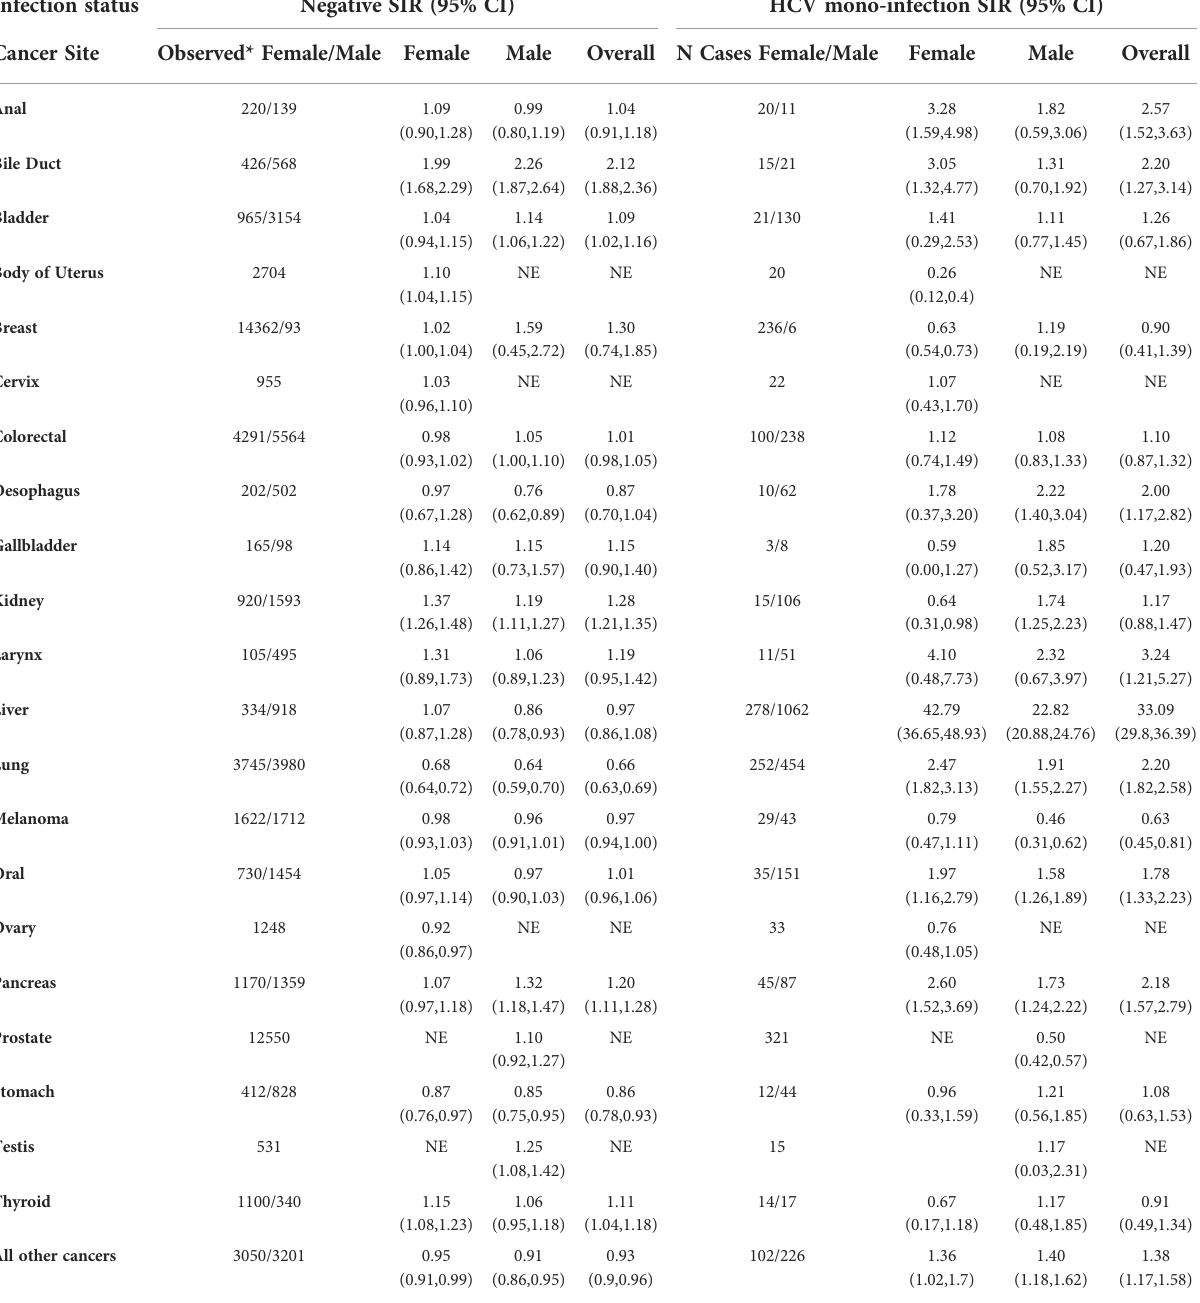
TABLE 2 Overall and gender-strati fi ed standardized incidence rates (SIRs) of cancer among negative and HCV mono-infected